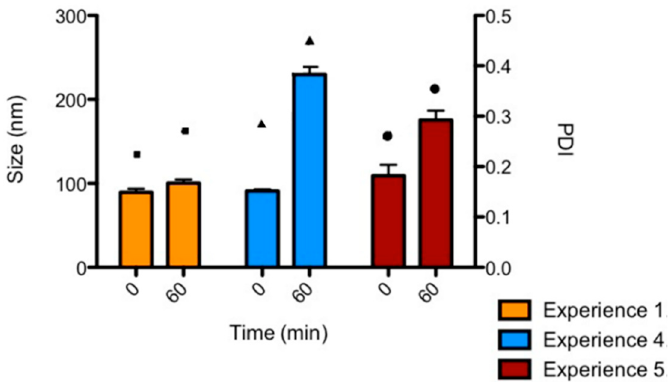
Figure 3. Results of the DoE. Contributions of the factors (in %) on: Size (bars, left axis) and PDI (squares, traangles and circles, right axis).